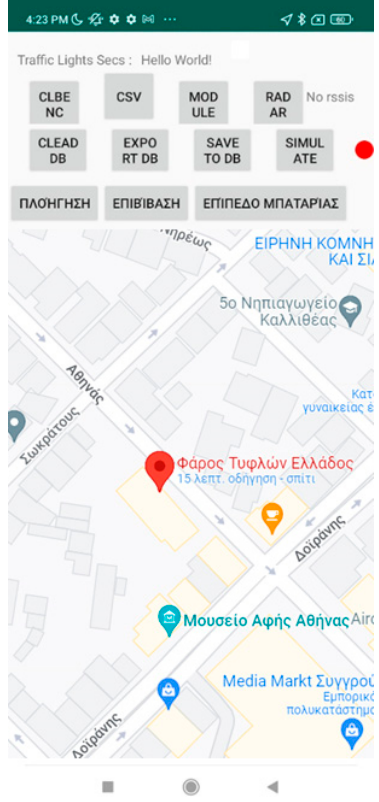
Figure 2. Application’s Training version—Main screen. It consists of three parts: the upper part contains the training app’s menu and the rest depicts the map, the user’s location and the navigational route. The Greek text on the last three buttons says, from left to right, “Navigation”, “Boarding”, and “Battery Level”.